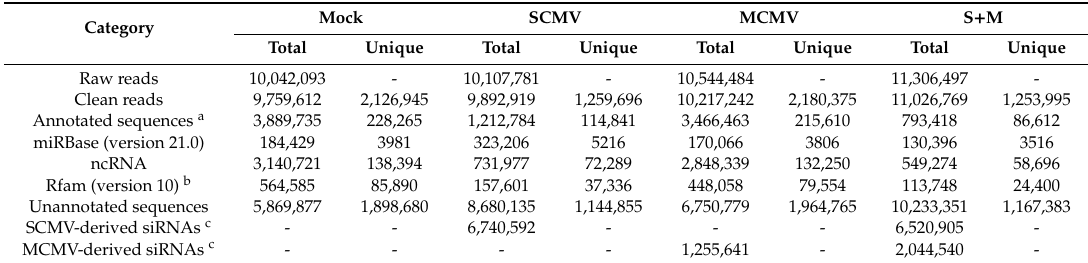
Table 1. Small RNAs from bu ff er (Mock)-, sugarcane mosaic virus (SCMV)-, maize chlorotic mottle virus (MCMV)-, and SCMV + MCMV (S + M)-inoculated maize plants.